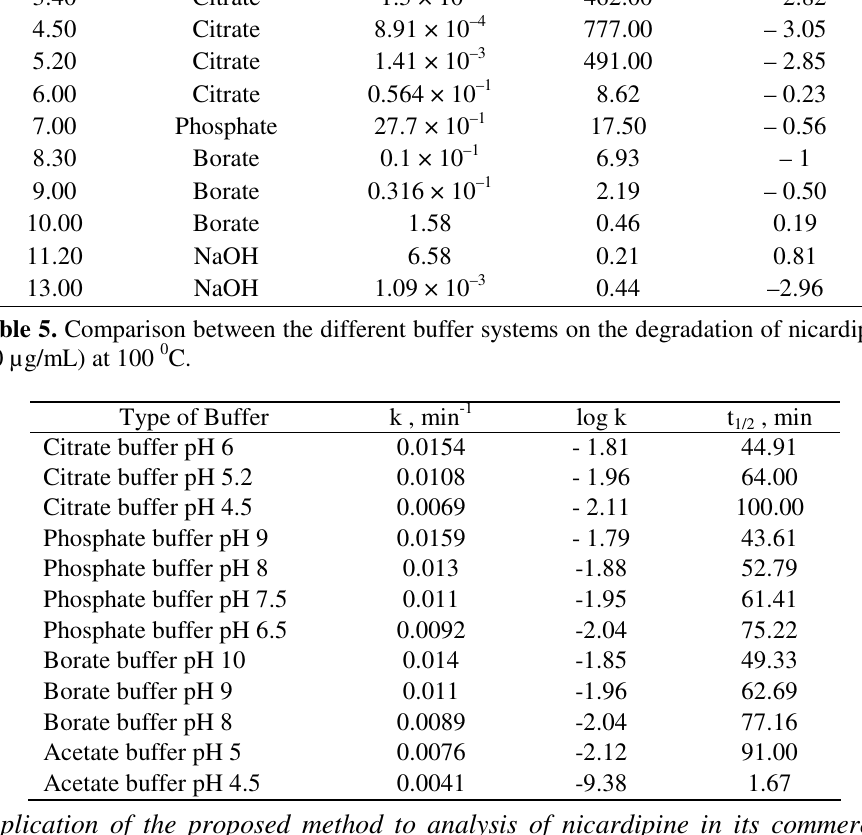
) and half-lives of degradation obs